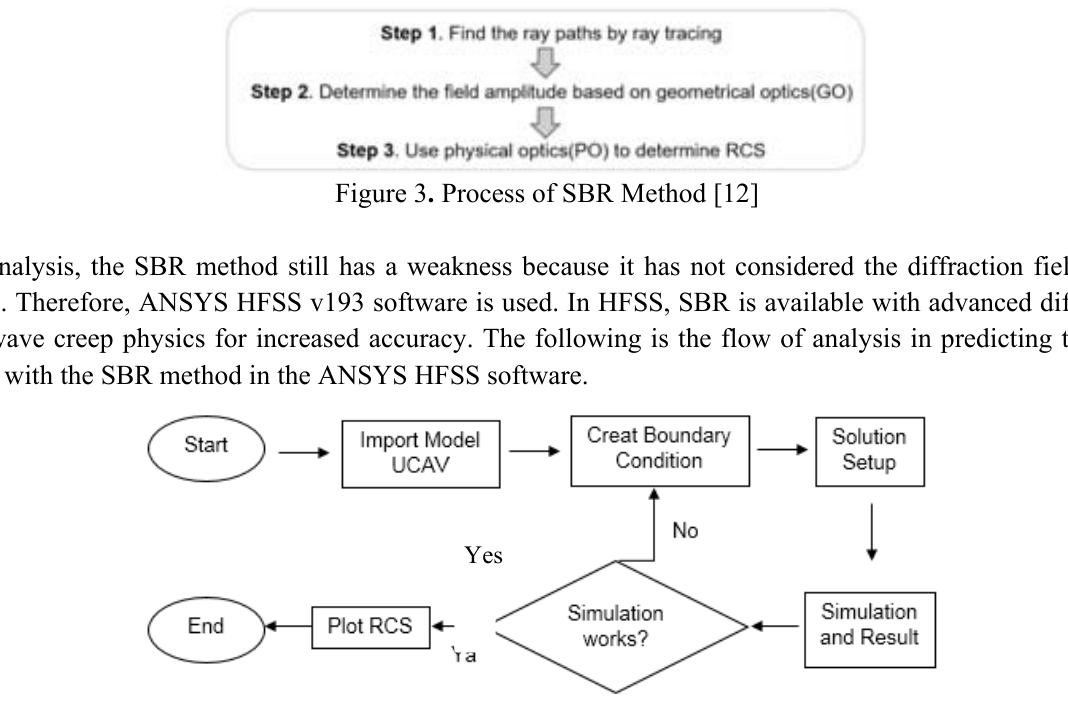
Figure 4. Flowchart of RCS analysis with the SBR method in the Ansys HFSS software.